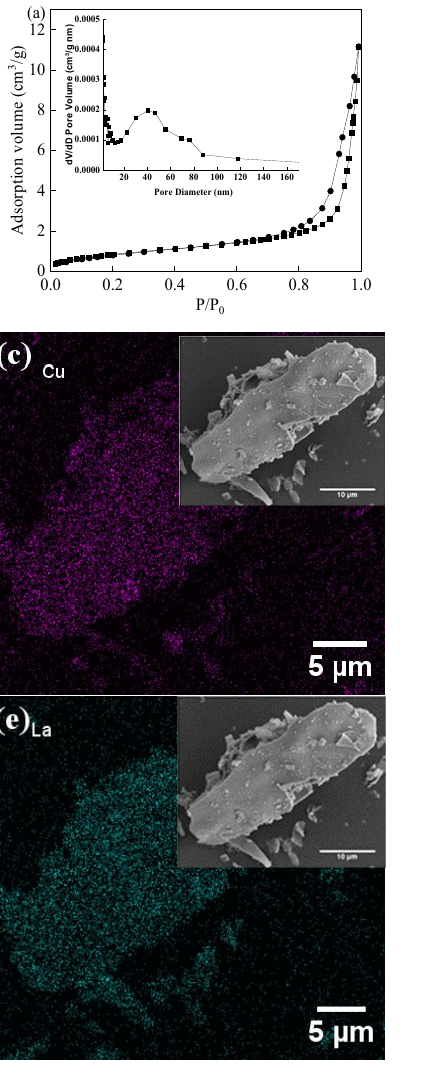
Figure 2. BET isotherm image ( a ) and SEM images and EDX spectra ( b ); Cu mapping ( c ); Fe mapping ( d ); La mapping ( e ); and O mapping ( f ) of LCFO-4.